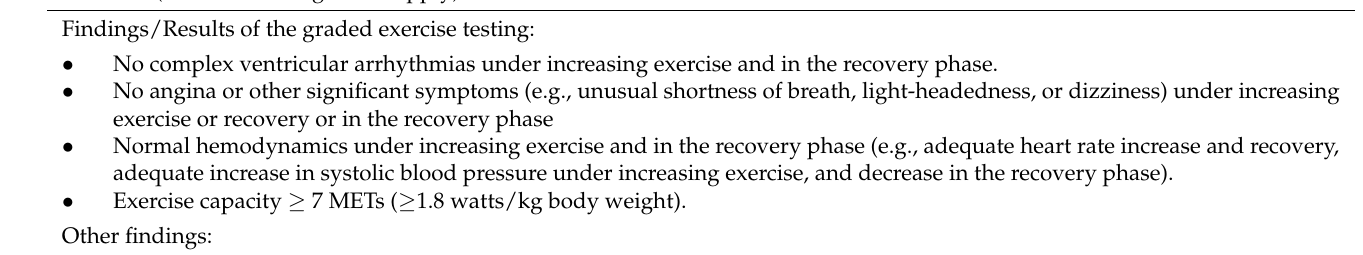
Table 2. Risk stratification regarding cardiac events during physical activity and exercise training in ebCR [2,15,37]. Low risk (all listed findings must apply) Findings/Results of the graded exercise